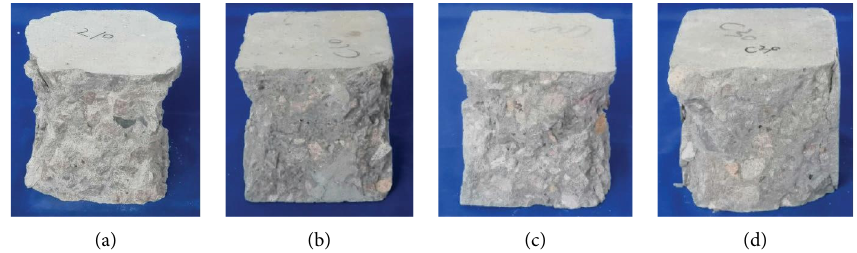
Figure 4: Compressive test destructive form. (a) SAC. (b) LSAC-10. (c) LSAC-20. (d) LSAC-30.